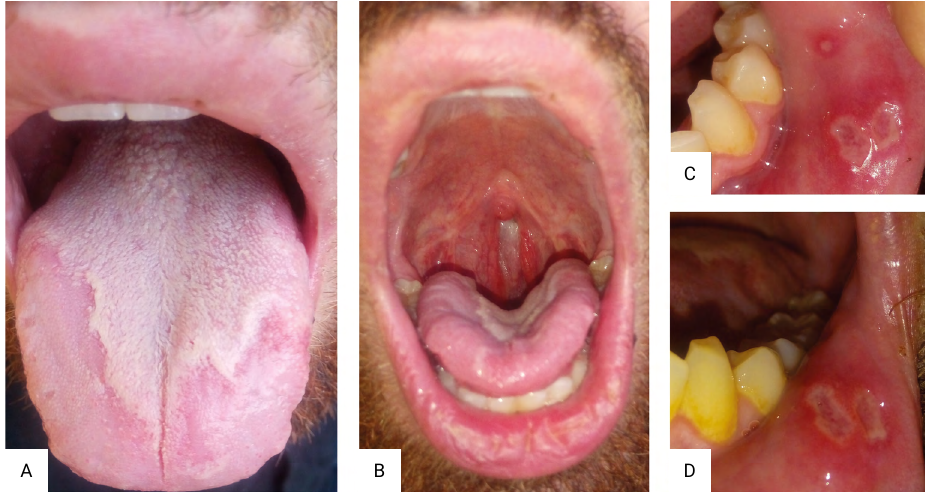
A Figure 1. Oral manifestations of the reported case; a: depapillated areas from the anterior and lateral parts of the tongue associated with burning sensation. b: erythema and purulent exudate from the posterior pharyngeal wall. c: after three days of onset of aphthous-like stomatitis. d: after four days of onset of apthous-like stomatitis erythematous irregular margins on the labial mucosa.